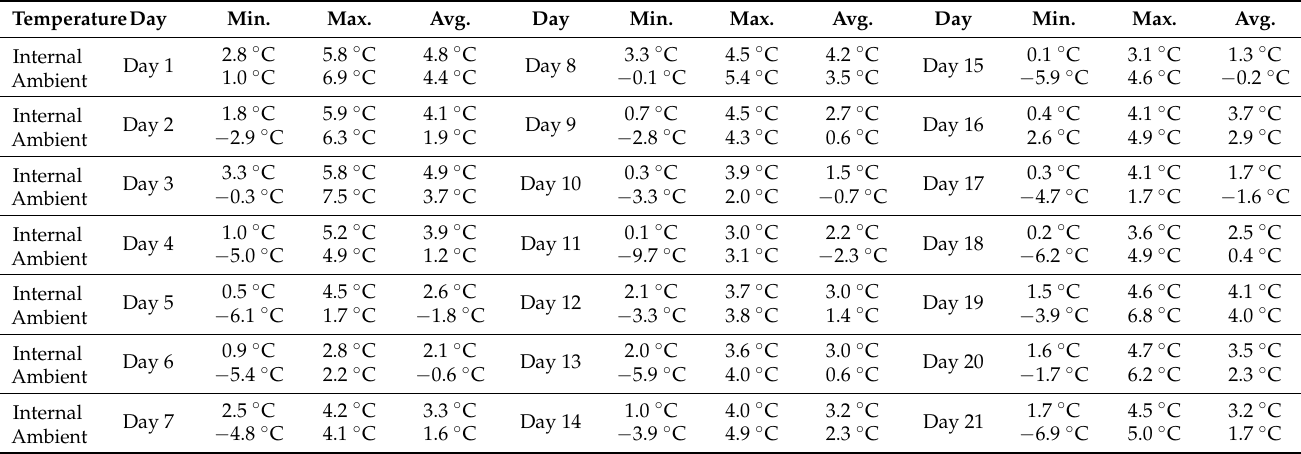
Table 4. The maximum, minimum, and average values of the internal temperature of the system and the ambient temperature over the 3-week test